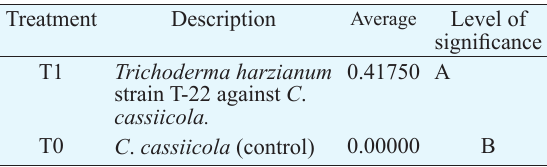
5. Results of the Tukey’s multiple comparison test for the percentage mycelial inhibition of Bacillus subtilis and Pseudomonas fluorescens against Corynespora cassiicola .